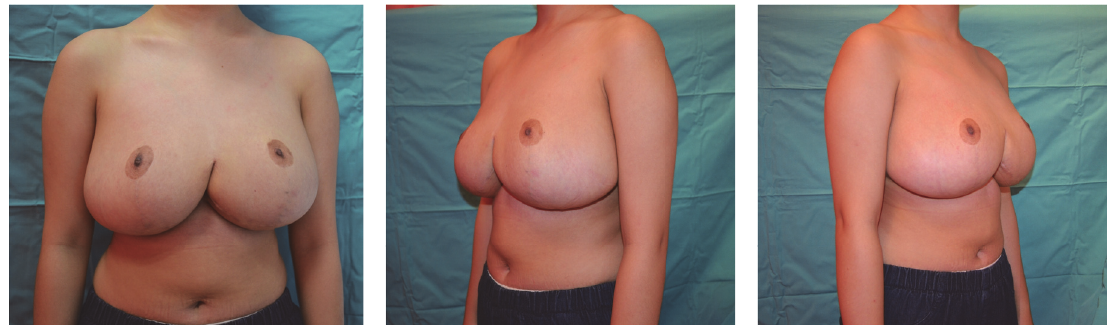
Figure 4: Postoperative views at a 5-year follow-up. No hypertrophic recurrence was observed. Note that the position of the NAC is slightly higher on the left and the breast demonstrates a boxy shape and bottomed-out